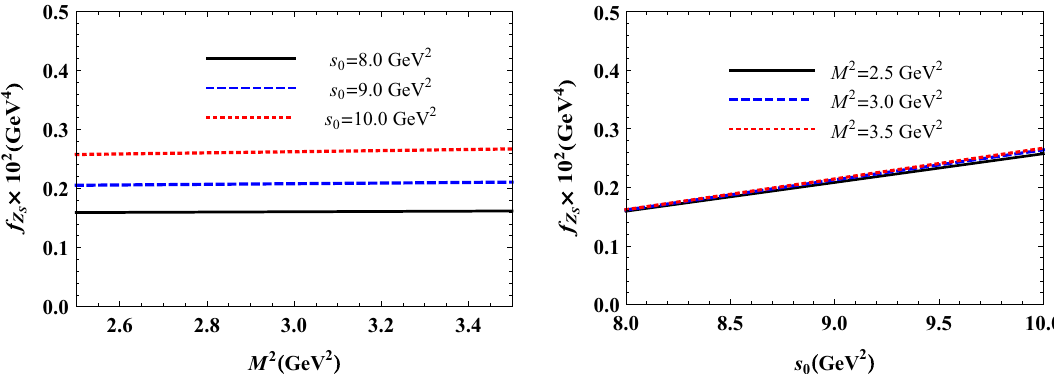
Fig. 5 The dependence of the current coupling f Z of the scalar Z S tetraquark on the Borel parameter at chosen values of s 0 (left panel), and on S the continuum threshold parameter s 0 at fixed M 2 (right panel)